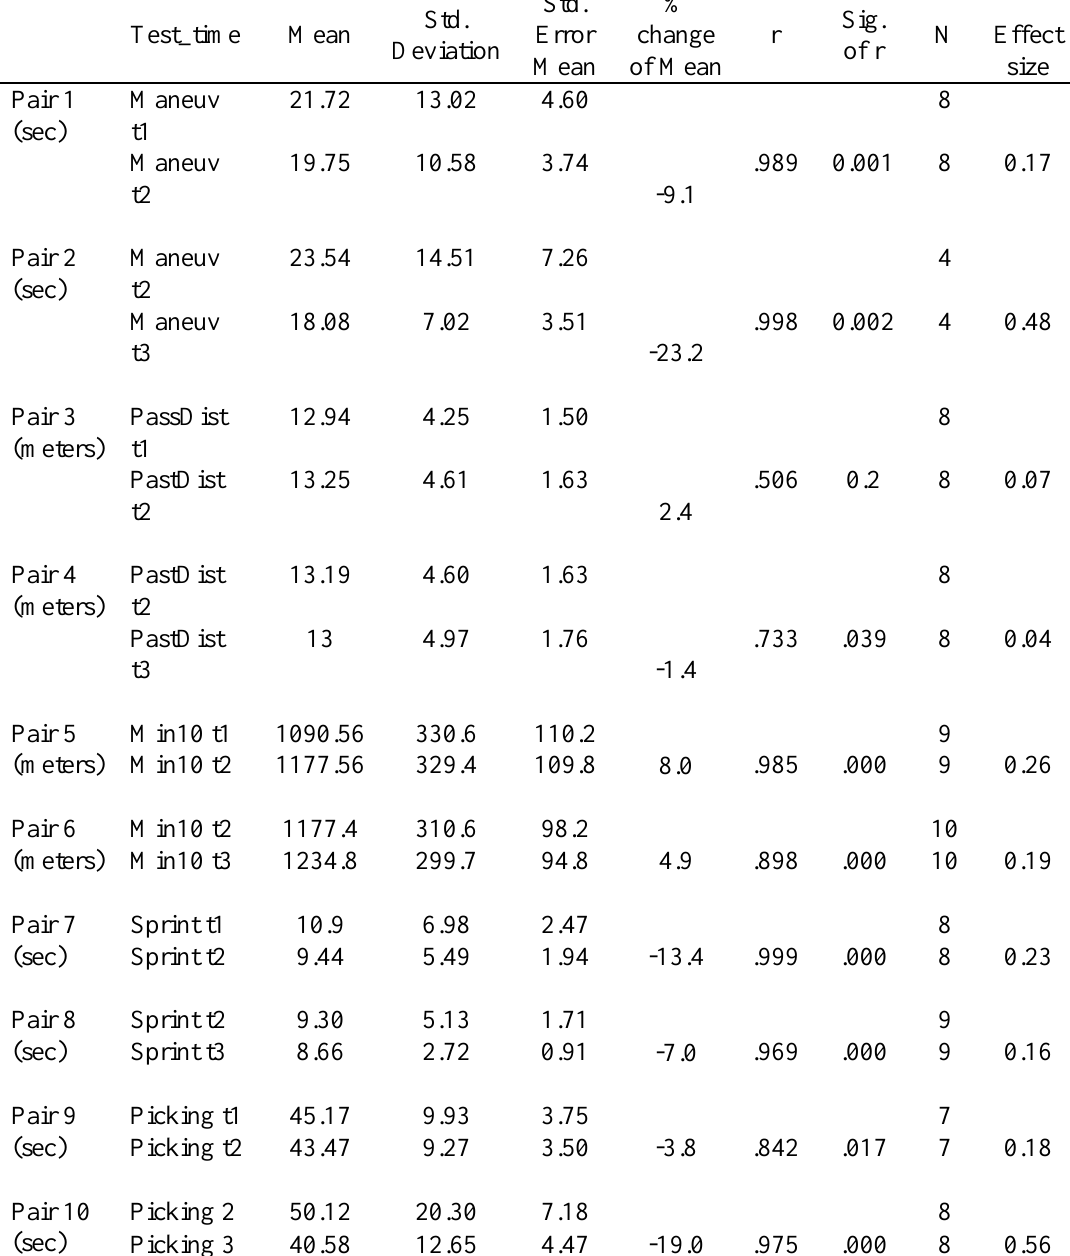
Table 3 Descriptive, change, and correlation values across tests and